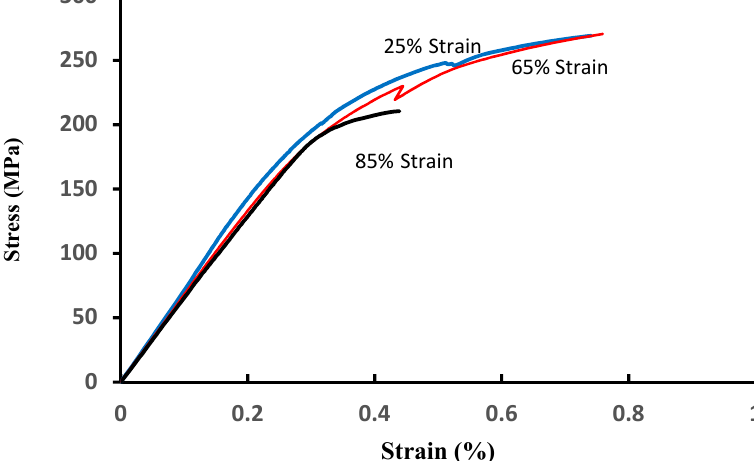
Figure 9. Stress / strain behavior of the cold-sprayed Al 6061-T6 deposits after 90 days of B-117 salt fog exposure.